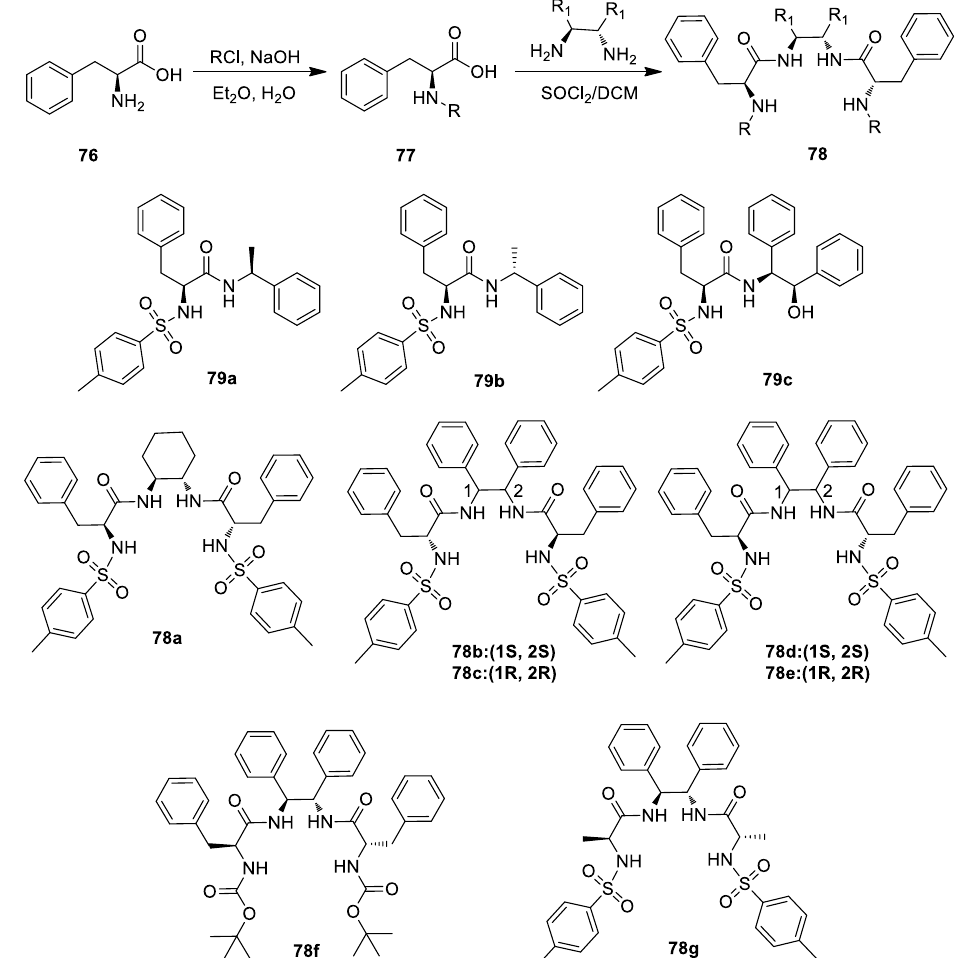
Scheme 29. Synthesis of C1- and C2-symmetric amino amide organocatalysts.